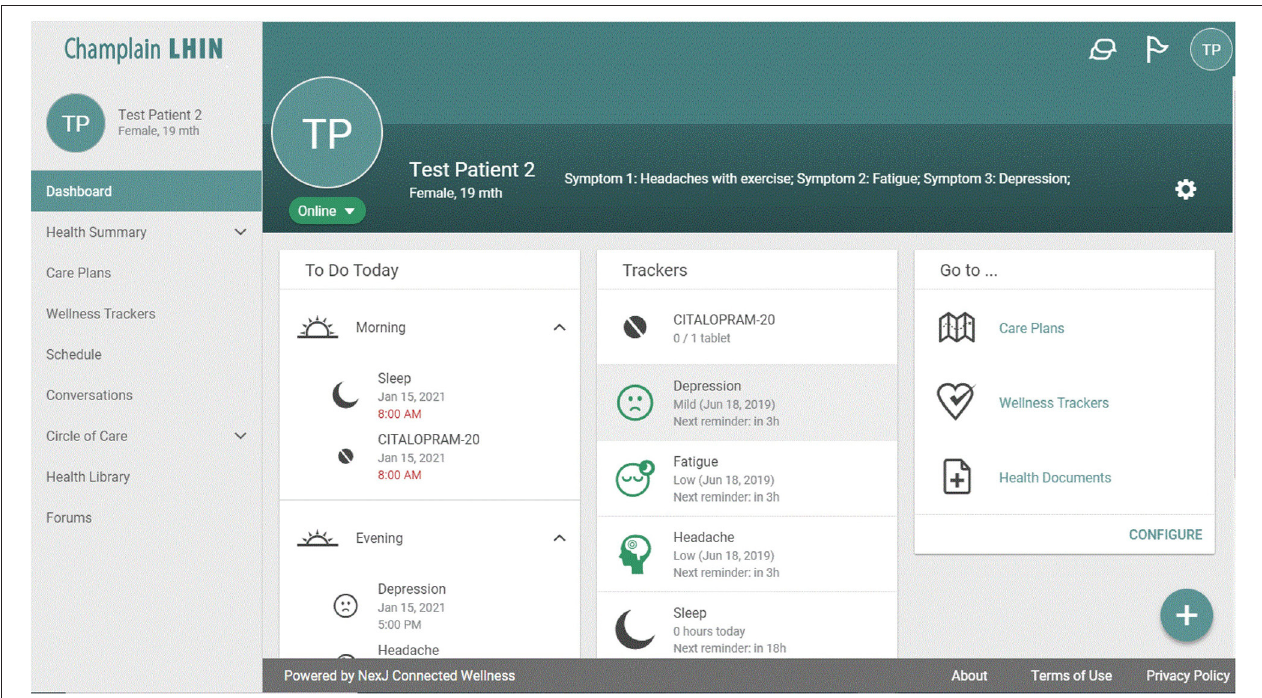
FIGURE 1 | Profile page of the App interface. Basic daily reminders and instructions guide patients on this